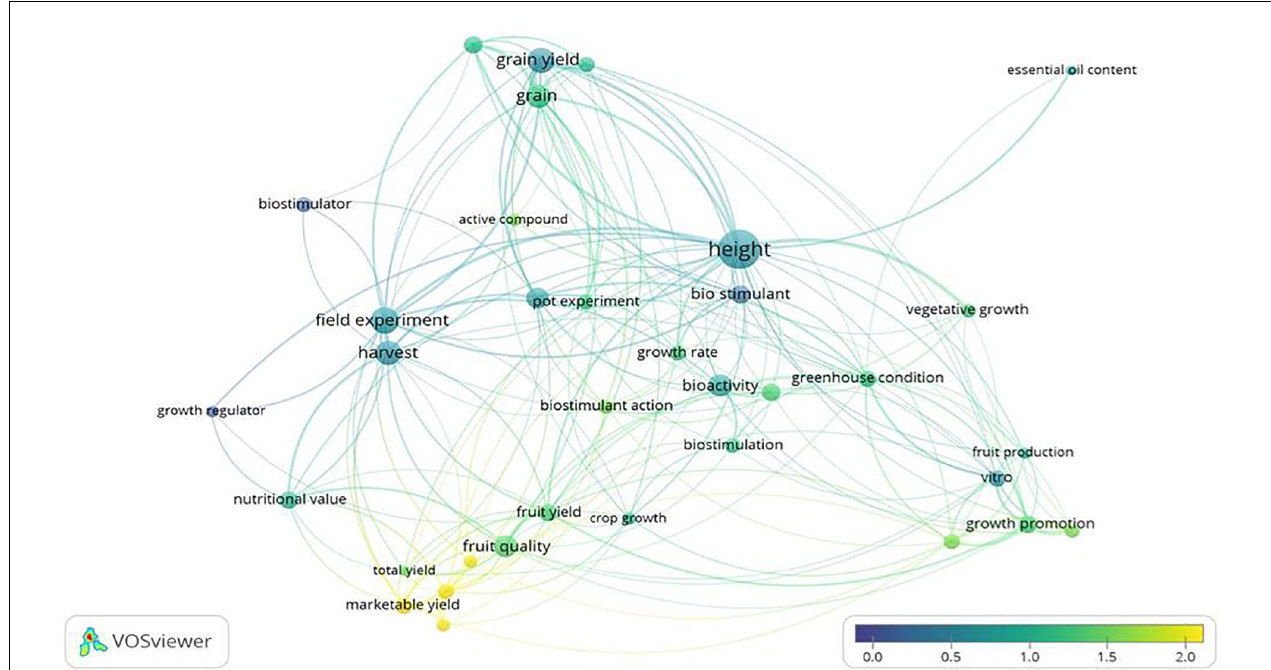
FIGURE 6 | Map of terms of the publications on biostimulants. The words “biostimulant” and “plant” were searched in the titles, abstracts and keywords, during the period from 2010 to 2020. The analysis is based on all the publications that are classified as Articles. The distance between terms indicates how strong their relationship is. The colour represents the normalised citation average, where blue is a low citation average and yellow is a high citation average. The size indicates the number of publications in which the term appears. References taken from WoS and Scopus.